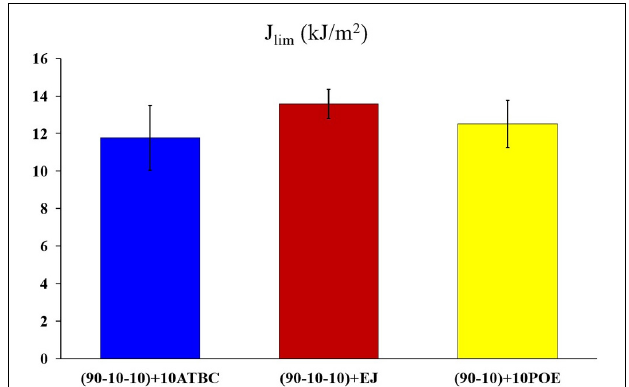
FIGURE 7 | J Ilim values for plasticized ternary blends.